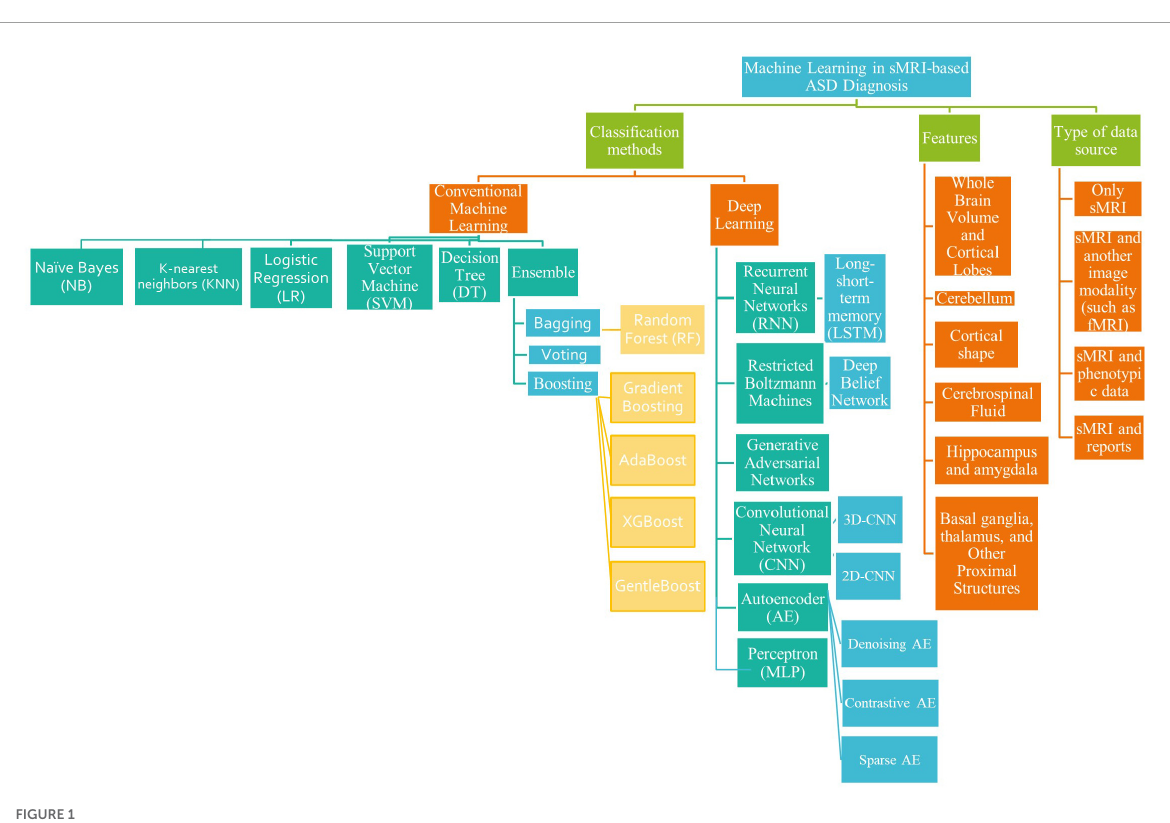
networks are the two main types of features that can be extracted from